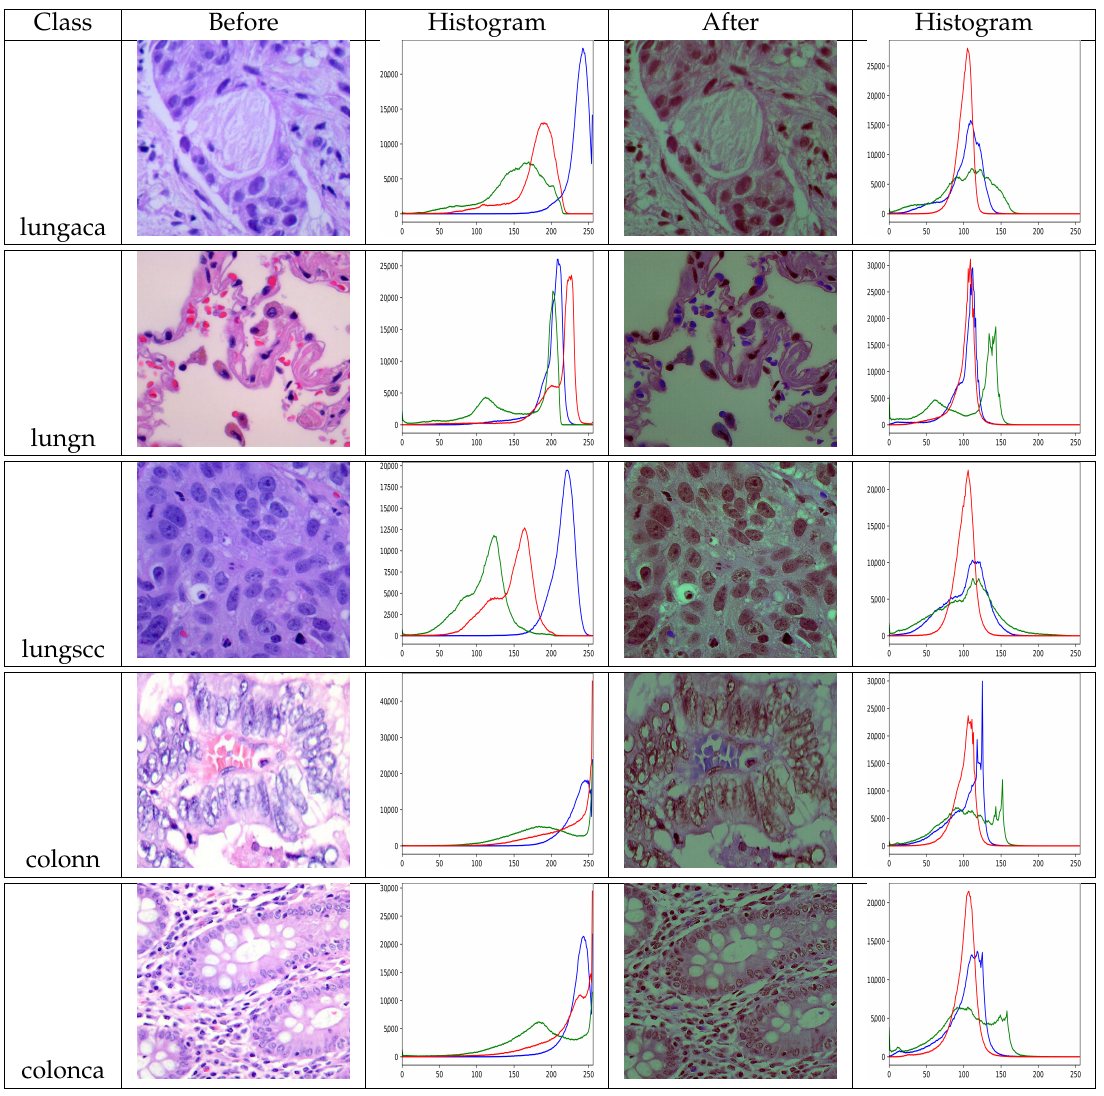
Figure 5. Histograms of original and pre-processed images before and after the pre-processing, lungaca: lung adeno- carcinomas, lungscc: lung squamous cell carcinomas, lungn: lung benign, colonca: colon adenocarcinomas, and colonn: colon benign.